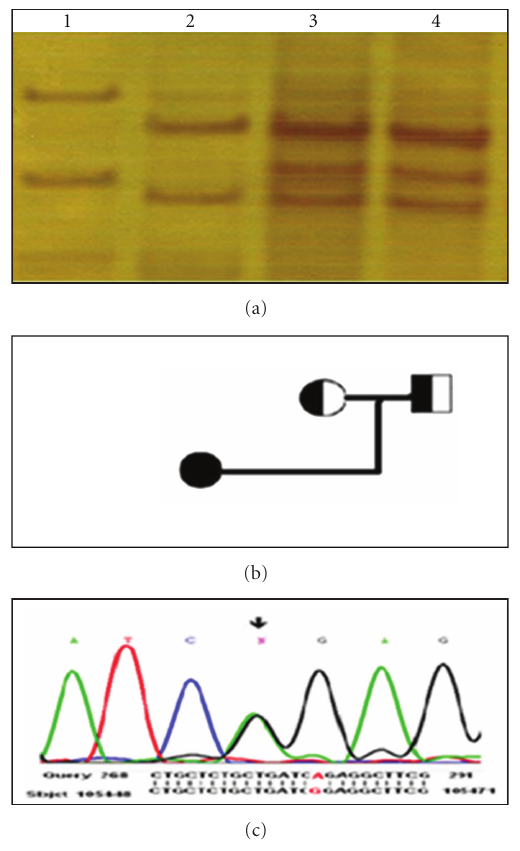
Figure 2: (a) SSCP analysis of exon 15 in a ff ected family. Line1: Normal control, Line2: The patient that has homozygous G2669A mutation in exon 15, Line3: The a ff ected s’ mother, Line4: The a ff ected s’ father. (b) Pedigree of the a ff ected family is aligned with the SSCP analysis. (c) Sequencing analysis result of a ff ected s’ mother and